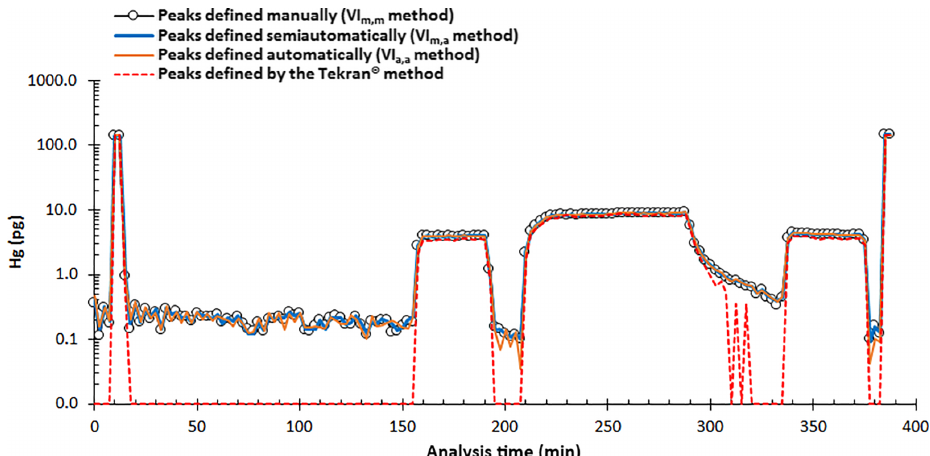
Figure 2. Test dataset collected with a Tekran ® 2537A instrument, represented as Hg loadings derived from my VI-based manual, semiau- tomated, and automated Hg thermal desorption peak height determination methods (the VI m,m , VI m,a , and VI a,a methods, respectively) and by the Tekran ® method. Peaks not detected by the Tekran ® method are assigned a value of 0.01pg. The two pairs of data points at > 100pg correspond with calibration gas analysis cycles (SPAN samples). I use the first pair of SPAN samples to initialize the VI (as described in Sect. 2.2). I use response factors calculated from the second pair of SPAN samples (and the preceding pair of blanks) to calculate Hg load- ings for all other samples in the dataset. The mean value of the baseline standard deviation, σ bl (defined in Sect. 2.1), is ∼ 0.03mV (equal to ∼ 0.03pg). The corresponding estimated lower-limit f value (mean ± 2 σ ; Sect. 2.3) is 1 . 86 ( 1 ) × 10 − 4